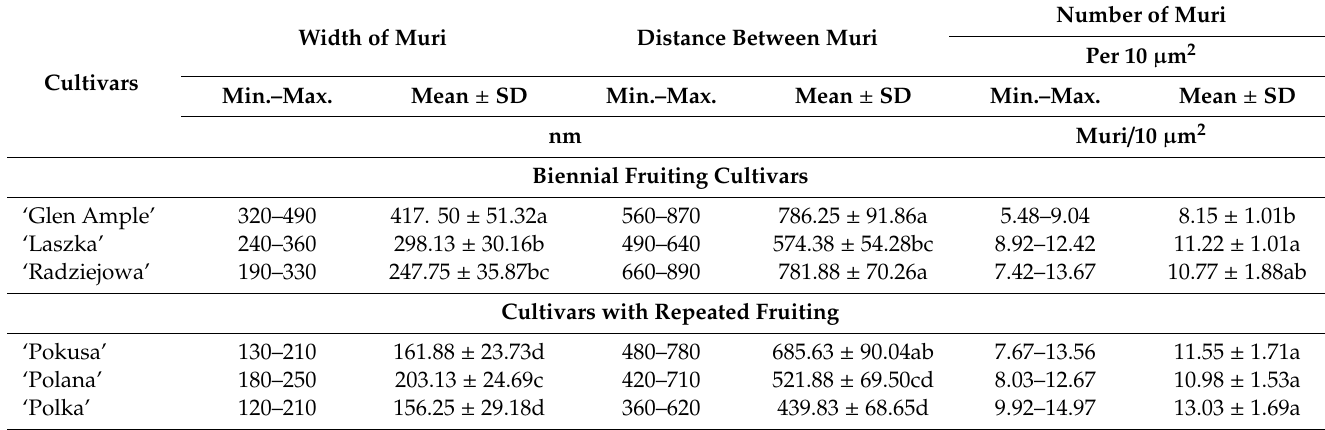
Table 2. Width of muri, distance between muri, and number of muri per unit area of exine in pollen grains of the examined R. idaeus cultivars. Width of Muri Distance Between Muri Cultivars